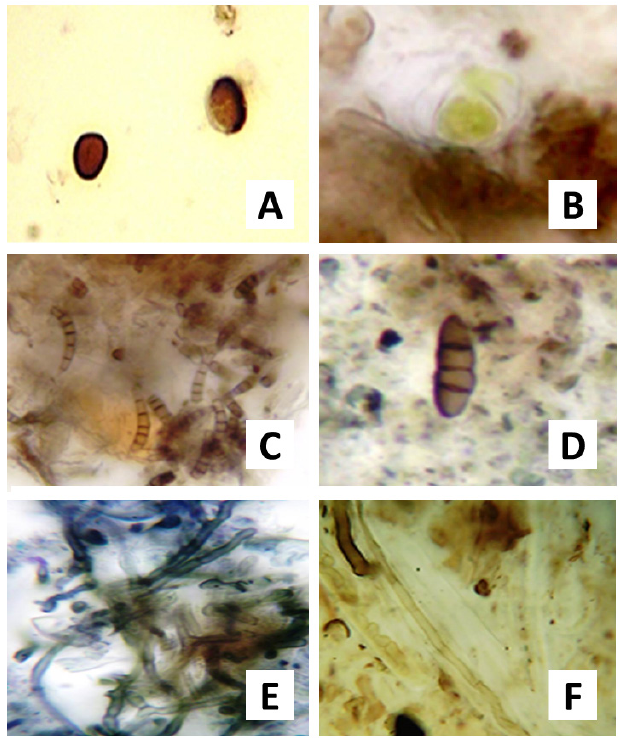
Fig 4. Lichen structures observed in the solid substrate of the crops of the workers of Constrictotermes cyphergaster after consuming lichens in the Semiarid Region of northeastern Brazil. Algae Cells (A and B); Fungal Cells (C and D); Fungal hyphae (E and